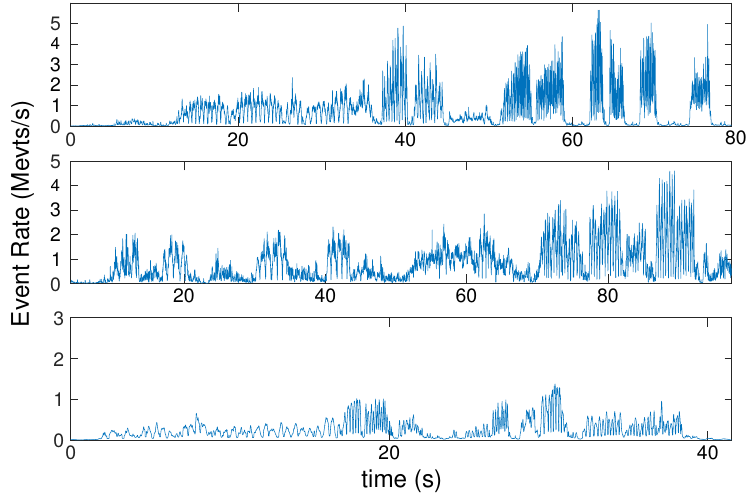
Figure 11. Event rates over time for each of the three tests. From top to bottom: BW planar, Objects, Lines.